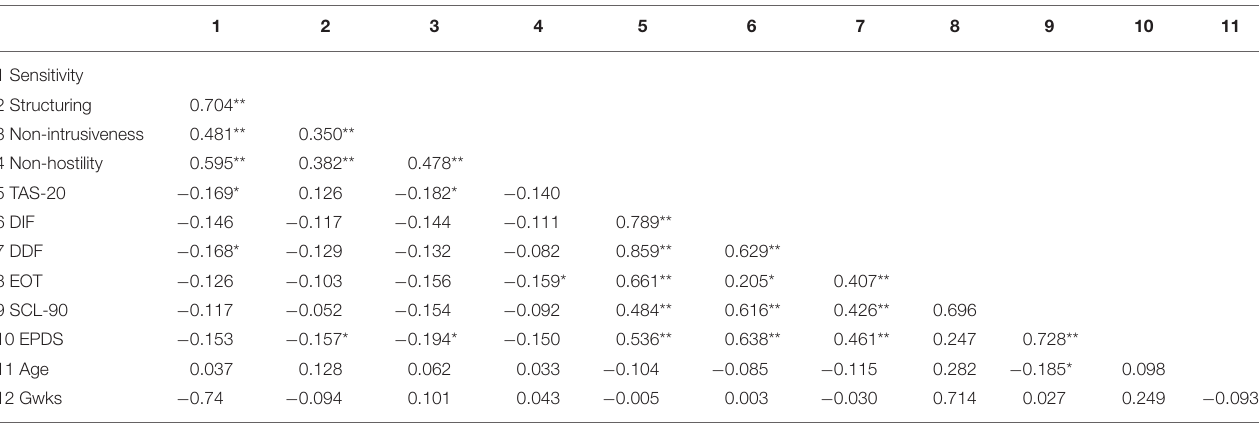
TABLE 2 | Spearman correlations for parental dimensions of Emotional Availability Scale, alexithymic traits, depressive and anxiety symptoms as well as maternal age and gestational weeks at time of birth of the child.